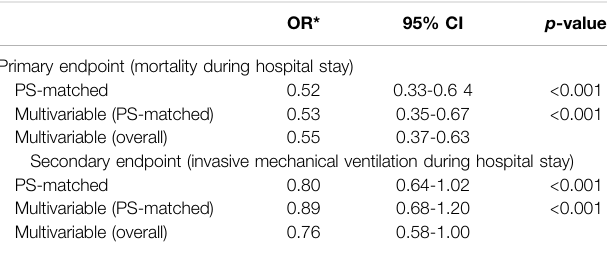
TABLE 5 | Clinical outcome in multivariable adjusted cohorts and propensity matched cohorts.